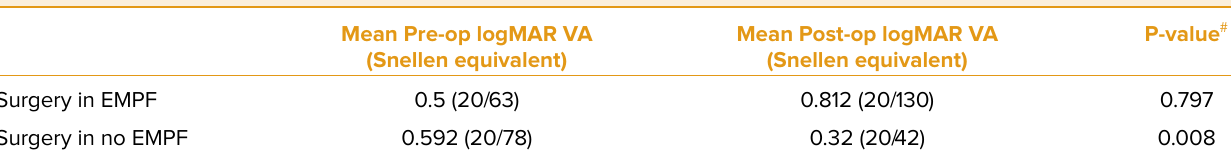
Table 4. Visual acuity changes before and after surgery in eyes with and without EMPF Mean Pre-op logMAR VA Mean Post-op logMAR VA P-value # (Snellen equivalent) (Snellen equivalent) Surgery in EMPF 0.5 (20/63) 0.812 (20/130) 0.797 Surgery in no EMPF 0.592 (20/78) 0.32 (20/42)